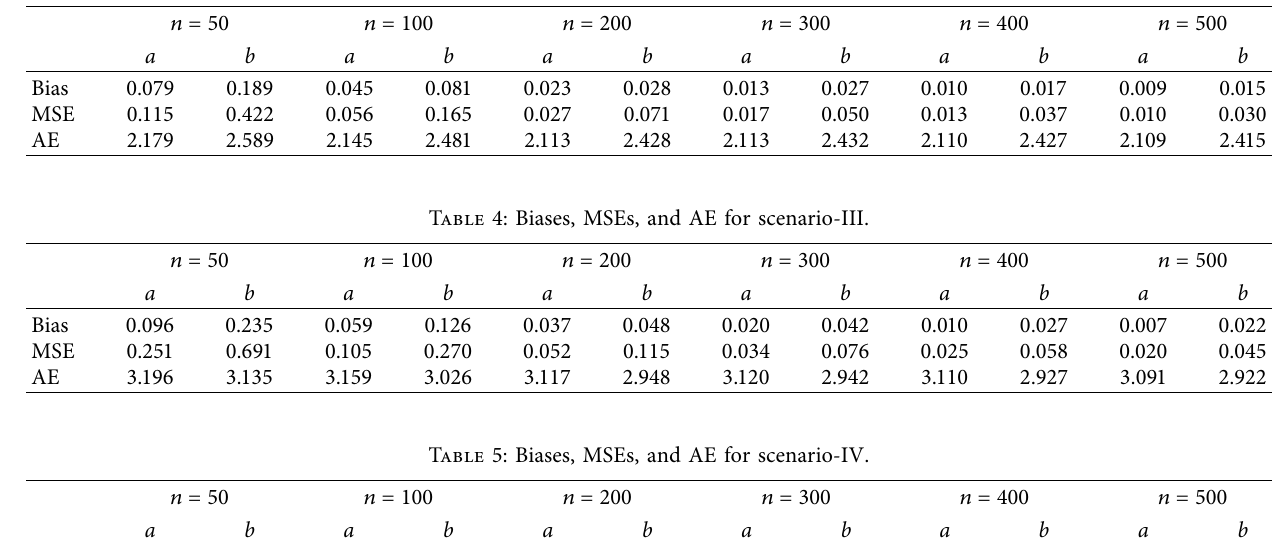
Table 3: Biases, MSEs, and AE for scenario-II.